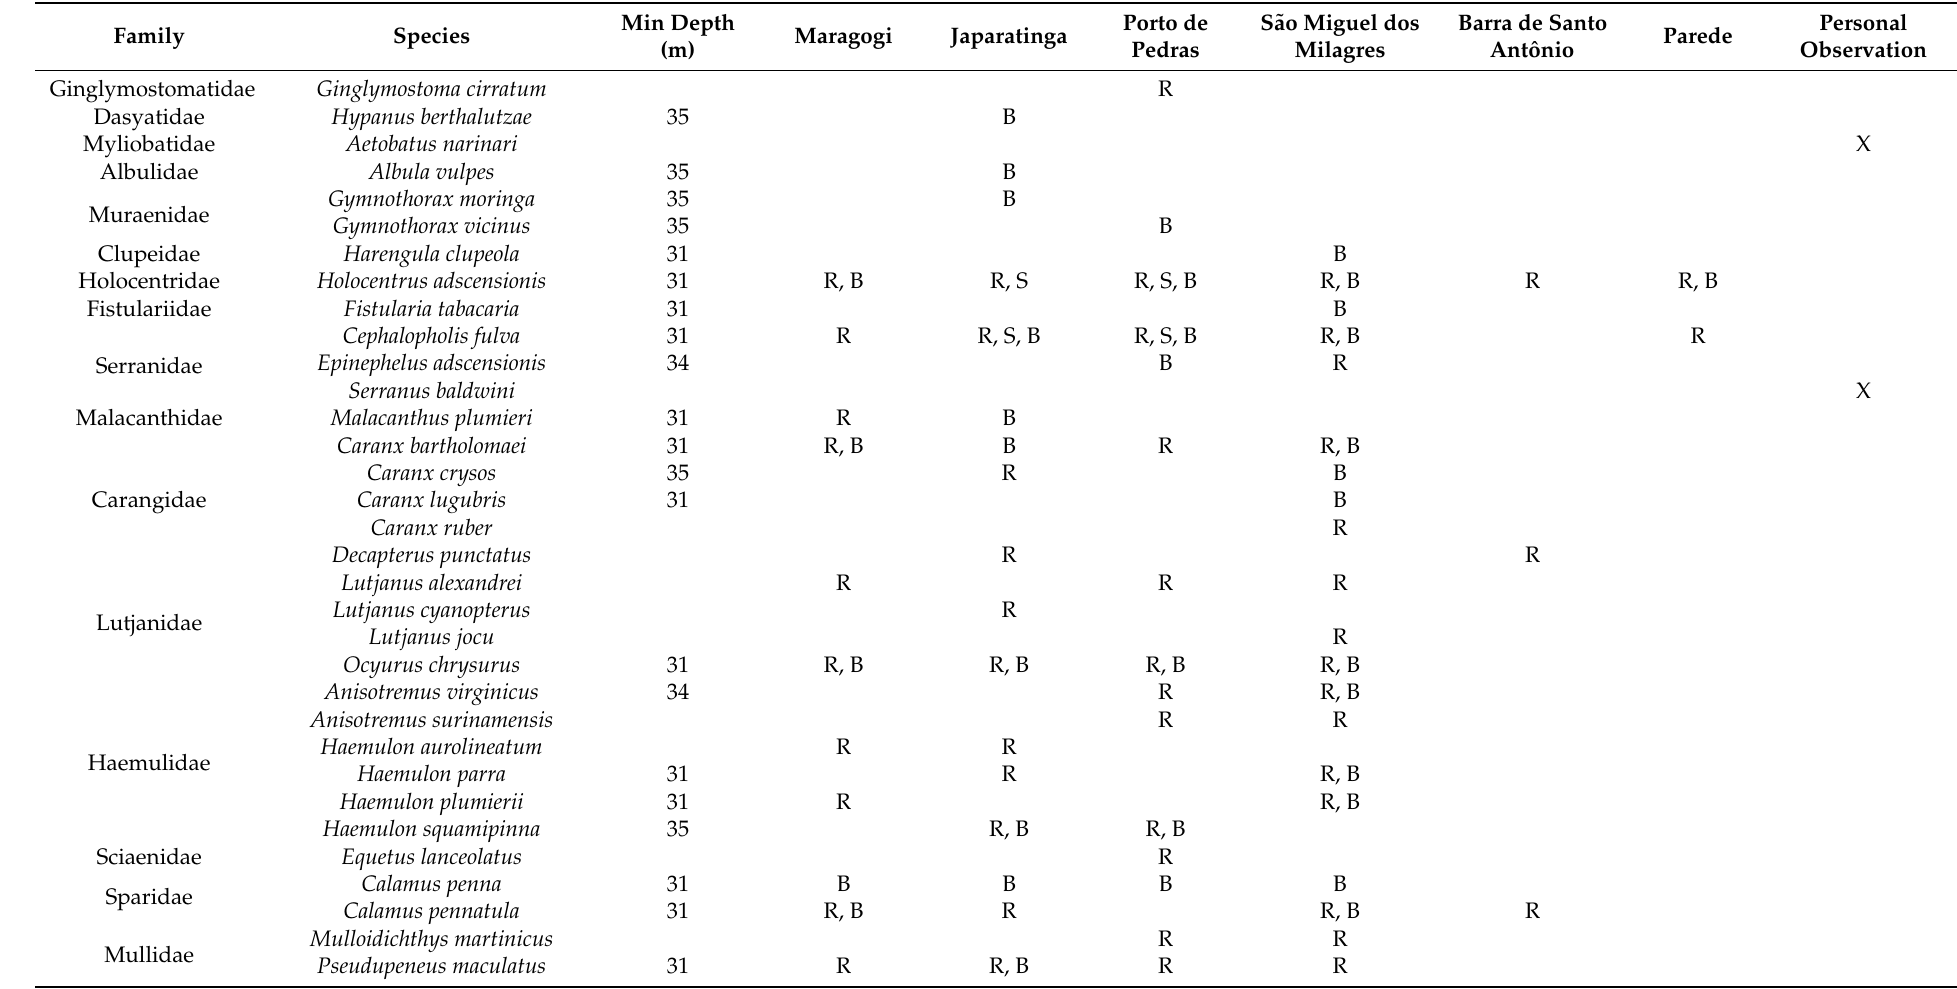
Table 4. Family and species of fish registered, along with identification of the location, minimum depth recorded, and methodology used, in the mesophotic zone of Marine Protected Area Costa dos Corais, Brazil. Personal observations are records made by researchers without using any methodology; in environments outside the transect or ROV image, for example. Depth data available in Table S1 (Supplementary